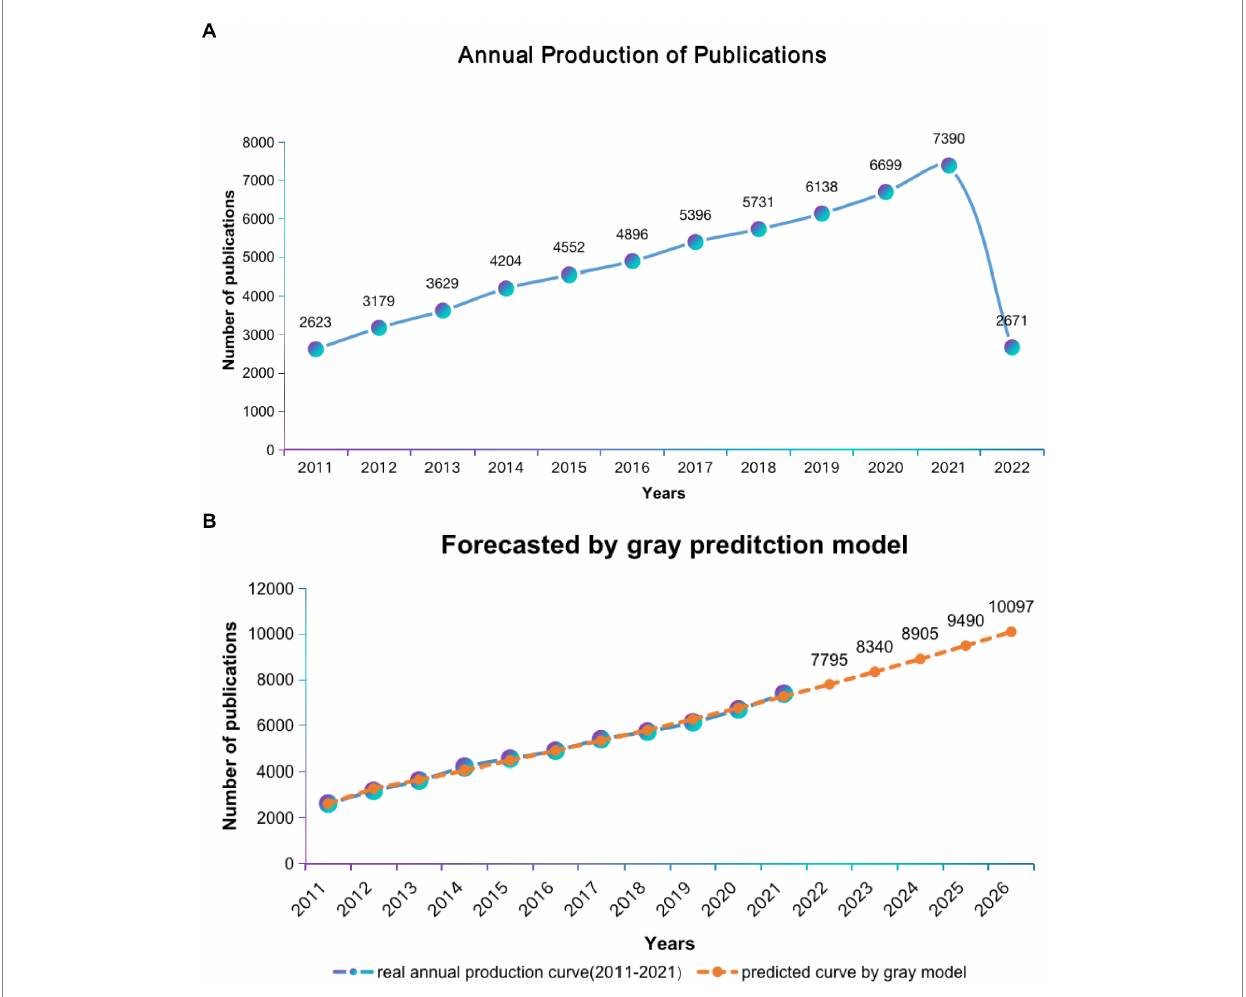
FIGURE 2 Global trends in publications of ASD research. (A) Single-year publication output over the past decade. (B) Model forecast curves for publication growth trends.